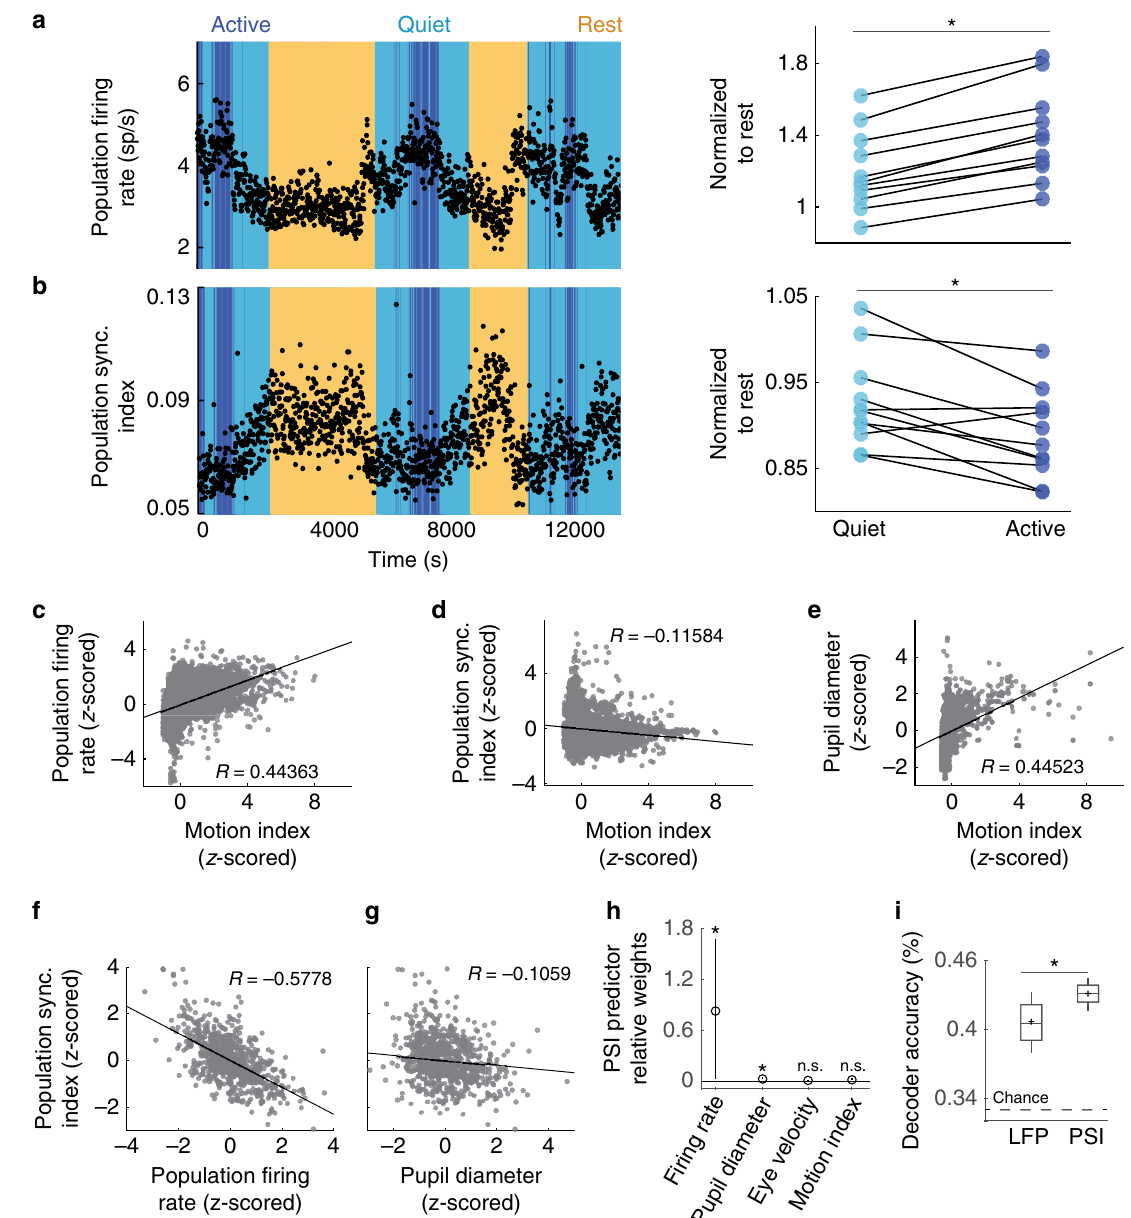
Fig. 3 Population activity during wakefulness is in fl uenced by behavioral state. Population fi ring rate ( a ) increases and PSI ( b ) decreases in progressively activated behavioral states (rest, quiet wakefulness, and active wakefulness). An example session (left) and a summary of all sessions normalized relative to rest (right) show signi fi cant differences in cortical state between active and quiet wakefulness (asterisks indicate Friedman test p < 0.001 and two-sided Wilcoxon signed-rank test with Bonferroni correction p < 0.01, n = 11 sessions). Pearson ’ s correlation demonstrates that active behavior is correlated with increased fi ring rate ( c ; R = 0.44363, p = 1e − 12, n = 8204 epochs), decreased PSI ( d ; R = − 0.11584, p = 6.5e − 26, n = 8204 epochs), and increased pupil diameter ( e ; R = 0.44523, p = 7.2e − 106, n = 2164 epochs). We performed a multiple linear regression to assess the relative contributions to PSI of population fi ring rate, pupil diameter, eye velocity, and motion index ( R = 0.2859, p < 0.001, n = 2164 epochs). 2D projections of this regression show the relationships of population fi ring rate ( f ) and pupil diameter ( g ) to PSI. Regression coef fi cients are − 0.5778 and − 0.1059, respectively. We